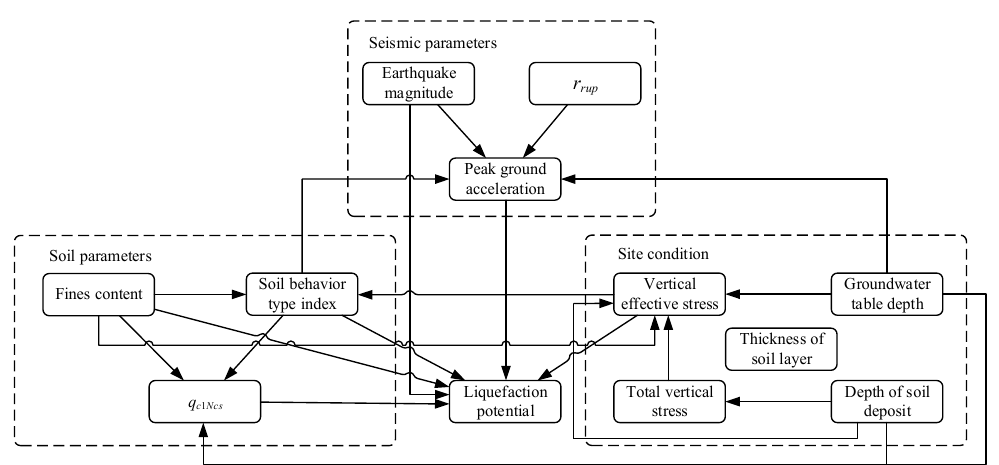
Figure 2. A Bayesian belief network (BBN) structure for seismic soil liquefaction potential based on the K2 machine learning (ML) algorithm and domain knowledge (DK).